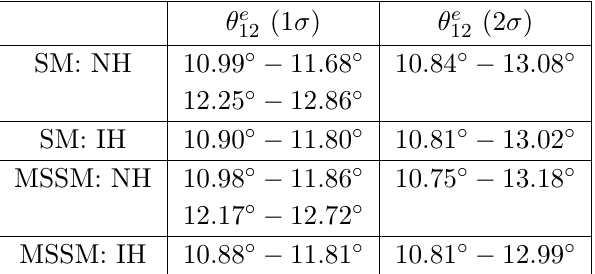
Table 1 . Viable 1 σ and 2 σ HPD intervals for θ e . The RG running effects have been considered in the case of the SM as well as of the MSSM θ PMNS 23 for both NH as well as IH, as discussed in the main